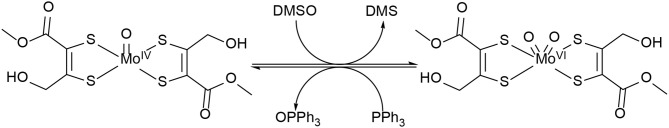
Proposed reactions for the oxygen atom transfer catalyzed by 5.